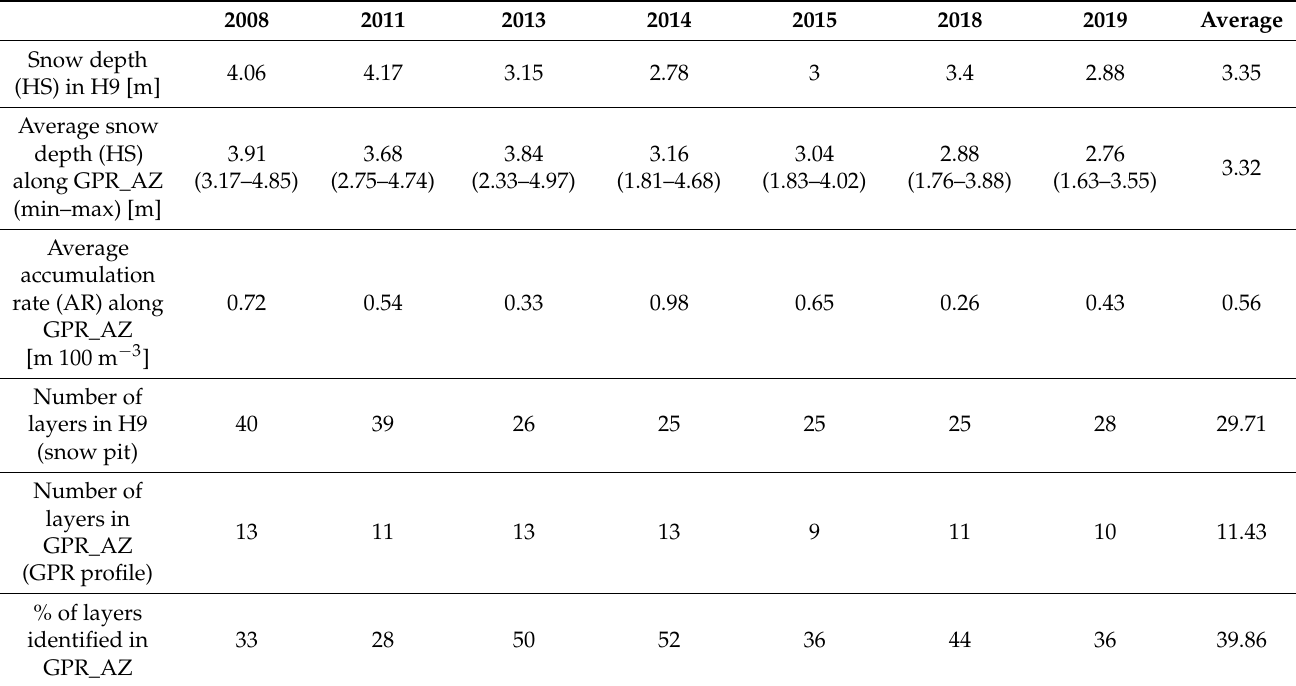
Table 2. Snow cover properties in